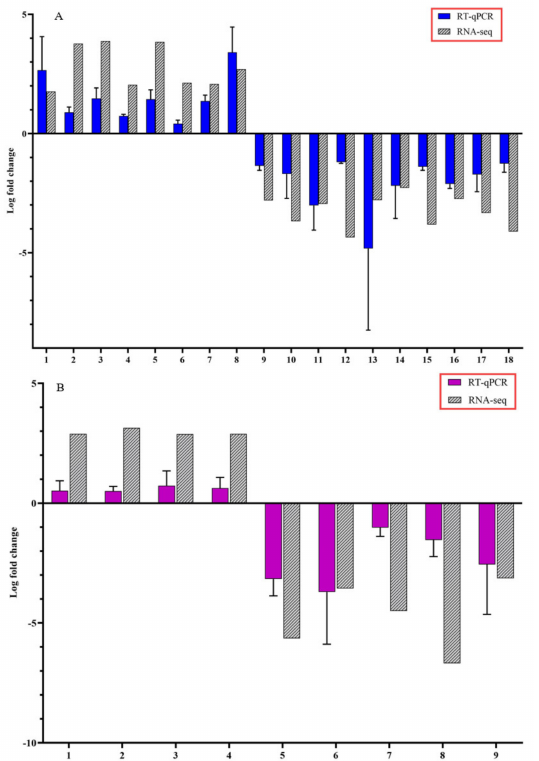
Figure 5. Expression pattern validation of selected candidate differentially expressed genes (DEGs) by reverse transcription-quantitative polymerase chain reaction (RT-qPCR) on stems and roots of citrus dwarfing viroid (CDVd) infected relative to non-infected citrus trees. The rela- tive gene expression was evaluated by the comparative Cq method using actin as a reference gene. The targeted DEGs used in the analysis for stems ( A ) were: (1) receptor-like protein 9DC3 (LOC102630240); (2) germin-like protein subfamily T member (LOC102611719); (3) penta- tricopeptide repeat-containing protein At2g17525 (LOC102610118); (4) MADS-box transcription factor 23-like (LOC102630220); (5) phospholipase A1-Ibeta2 (LOC102609966); (6) protein TIC 55 (LOC102614849); (7) pentatricopeptide repeat-containing protein At1g08070 (LOC102619843); (8) tran- scription factor MYB13 (LOC102616893); (9) SKP1-like protein 21 (LOC102620512); (10) amino- acid permease BAT1-like (LOC102620992); (11) LOC102627502 pentatricopeptide repeat-containing protein At4g21300; (12) uncharacterized protein (LOC102608277); (13) protein SHORT-ROOT-like (LOC102610900); (14) protein IQ-DOMAIN 1, transcript variant X1 (LOC102628194); (15) hydroxypro- line O-galactosyltransferase GALT3, transcript variant X3 (LOC102626136); (16) cytochrome P450 82C4-like; (17) LOC102622795 thaumatin-like protein 1 (LOC102619709); (18) Plant uncharacterized (LOC102625692). Targeted DEGs used in the analysis for the roots ( B ) were: (1) Plant invertase/pectin methylesterase inhibitor superfamily protein (Ptrif.0009s1914.1); (2) S-adenosyl-L-methionine- dependent O-methyltransferase/ethylene-responsive transcription factor ERF114 (Ptrif.0005s1389.1); (3) C2H2-like zinc finger protein (Ptrif.0005s2465.1); (4) Pentatricopeptide repeat (PPR) super- family protein (Ptrif.0006s1595.1); (5) Kinase-inducible domain interacting 9 (Ptrif.0001s0240.1); (6) Pentatricopeptide repeat (PPR-like) superfamily protein (Ptrif.0003s3971.1); (7) zinc-finger pro- tein 10 (Ptrif.0006s0692.1); (8) Calcium-dependent lipid-binding (CaLB domain) family protein (Ptrif.0003s4060.1); (9) GNS1/SUR4 membrane protein family (Ptrif.0005s2586.1). Error bars for the RT-qPCR are standard